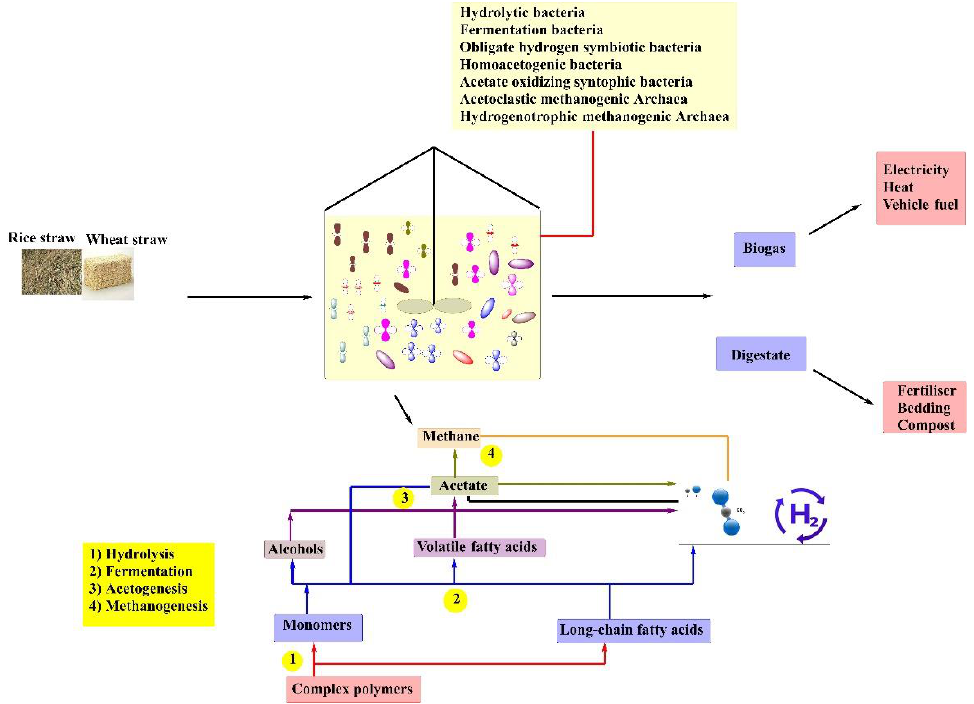
Figure 4. Different stages of anaerobic digestion of waste materials and their conversion to electric- ity.